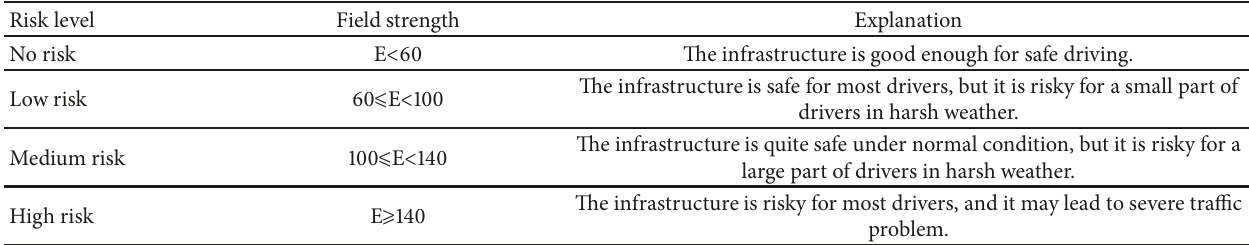
Table 7: Risk levels of road infrastructure (case